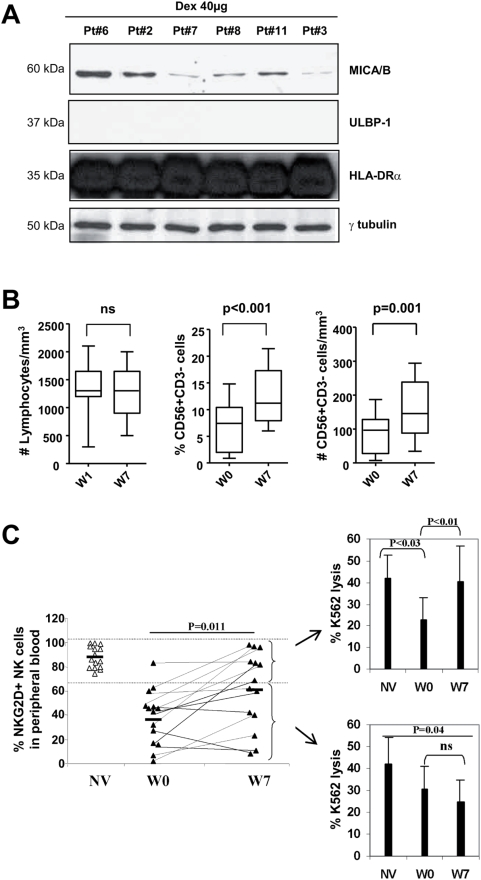
Vaccination of melanoma patients with Dex restored NKG2D-dependent NK cell function.A. Patients' Dex harbour MICA/B molecules. Western Blot immunodetection of NKG2D-L using anti-MICA/B and anti- ULBP-1 Abs (not detected) on 40 µg of Dex proteins. B. Dex enhanced the numbers of circulating NK cells in melanoma patients. Enumeration of lymphocytes (left panel) and flow cytometry determination of the percentages (middle panel) and absolute numbers (right panel) of CD3− CD56+NK cells in PBMC prior to (W0) and following Dex vaccination (W7) in the Phase I trial enrolling 14 melanoma patients. C. Restoration of NKG2D expression and function by Dex therapy in melanoma. Flow cytometry analyses of NK cells using anti-NKG2D or isotype matched control mAb, anti-CD3, and anti-CD56 mAbs were performed on PBL of normal volunteers (NV) or of patients before Dex therapy (W0) and after Dex therapy (W7). Purified autologous NK cells from 14 patients enrolled in the Phase I trial at W1 or W7 or from 10 NV were investigated for cytotoxic activity against 51Cr labeled K562 cells at a 10∶1 (shown) and 2∶1 (not shown) E∶K562 ratio. Two tests per individual were run yielding identical results. Intra-individual variations were <10%. Means±SD for 10 normal volunteers (NV), for 14 melanoma patients before Dex therapy (W0) and after Dex therapy (W7) are represented. The upper panel depicts the NK cell cytotoxicity when NKG2D expression levels were restored at W7 (>70%) in contrast to the lower panel indicating the NK cell cytotoxicity in patients whose NKG2D expression remained low (<70%). * p<0.05 and ns: non significant.